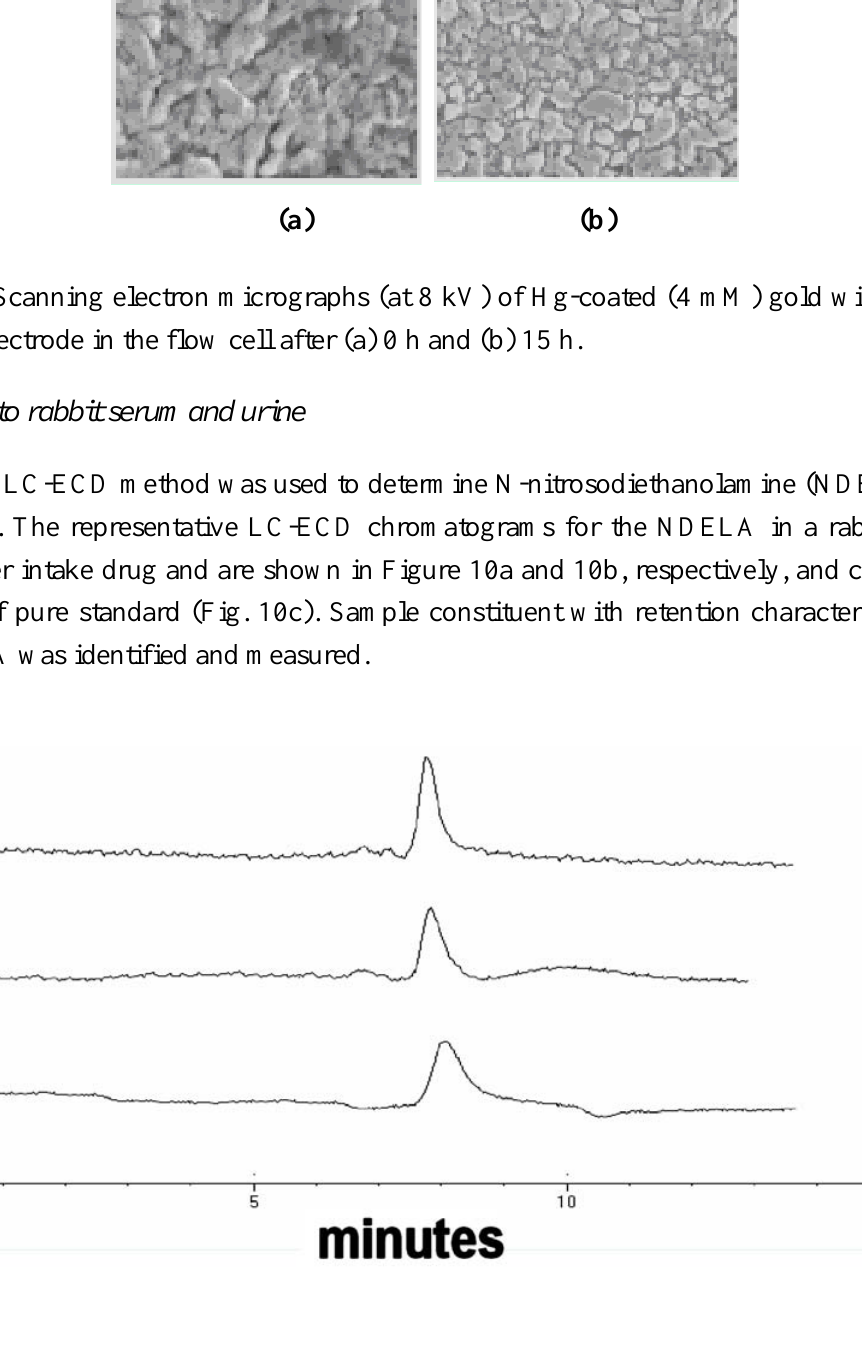
Figure 10. LC-ECD chromatograms obtained from rabbit biological fluids after oral administration of NDELA (60 mg): (a) serum (b) urine (c) NDELA standard. Stationary phase, Phenomenex Luna CN column (particle size 5 µ m, 250 mm × 4.6 mm i.d.). Mobile phase, methanol:water (10:90, v/v) containing 0.2 mM lithium perchlorate; flow rate, 0.3